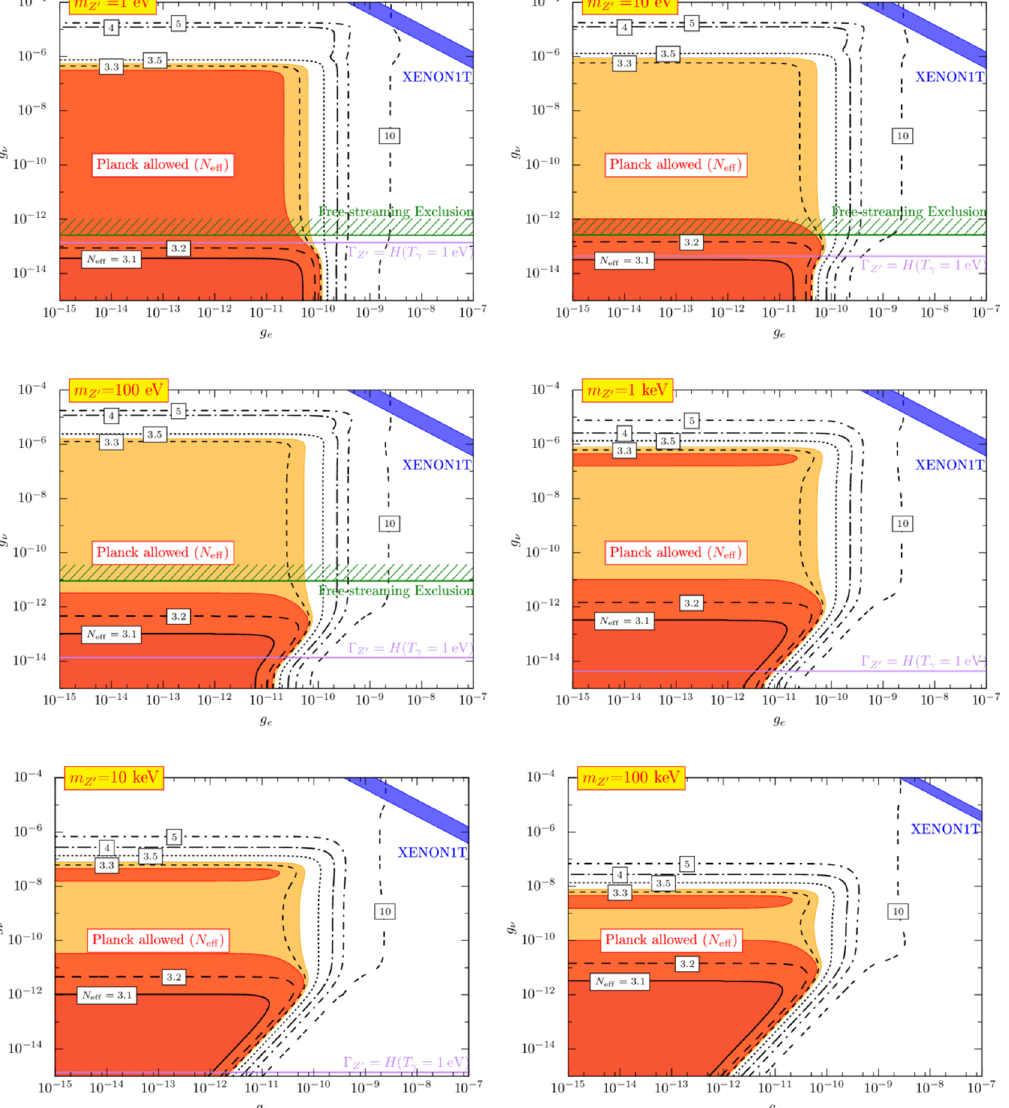
Figure 3. The contour plot of N eff on the ( g e , g ν ) plane for a given mediator mass. Here, we assume that the mediator couples to one flavor of the three neutrinos. The dark-orange (light- orange) shaded regions are consistent with the Planck CMB only (joint Planck+BAO) constraint, N eff = 2 . 92 +0 . 36 ( 2 . 99 +0 . 34 ) at 95% C.L. The green line corresponds to the neutrino free-streaming − 0 . 37 − 0 . 33 bound [32]. The blue bands are the regions favored by the XENON1T excess. The horizontal purple lines show the parameter at which the total decay rate of the Z 0 boson is compatible with the Hubble rate at the CMB era in the standard